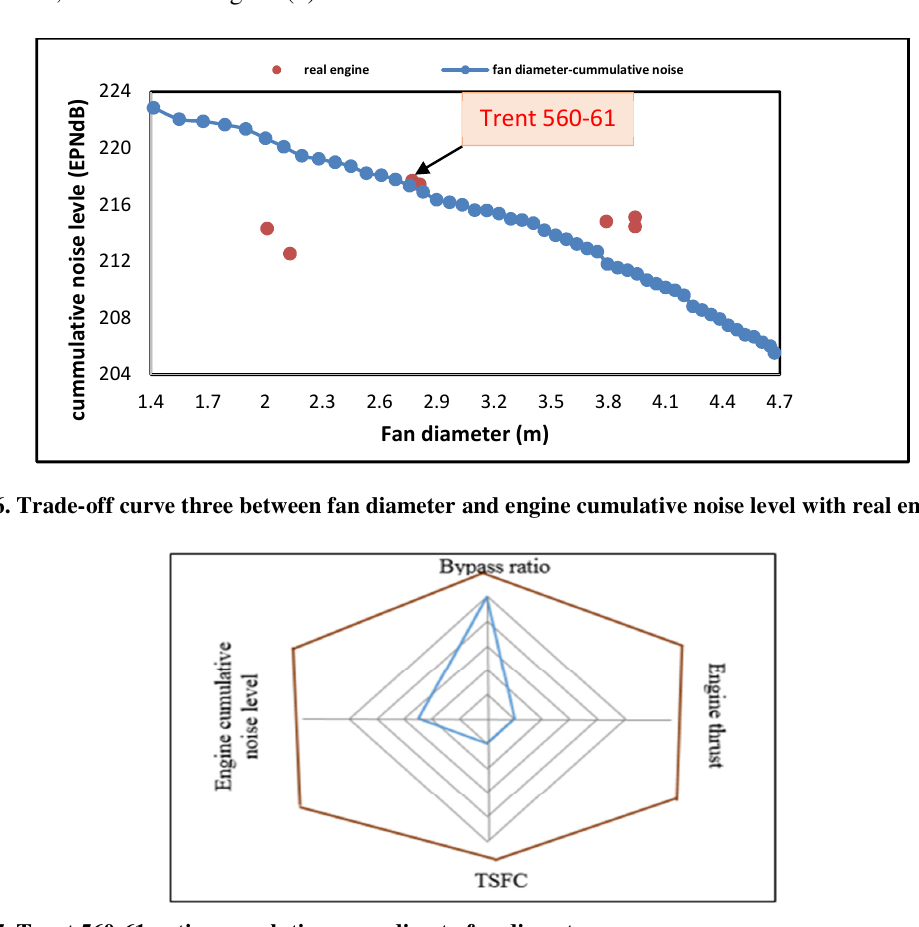
Fig. 7. Trent 560-61 optimum solution according to fan